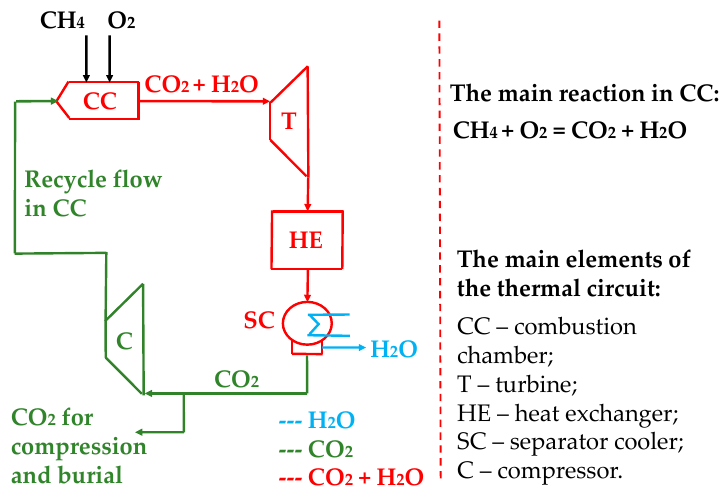
Figure 2. Schematic diagram of the oxygen-fuel energy complex.